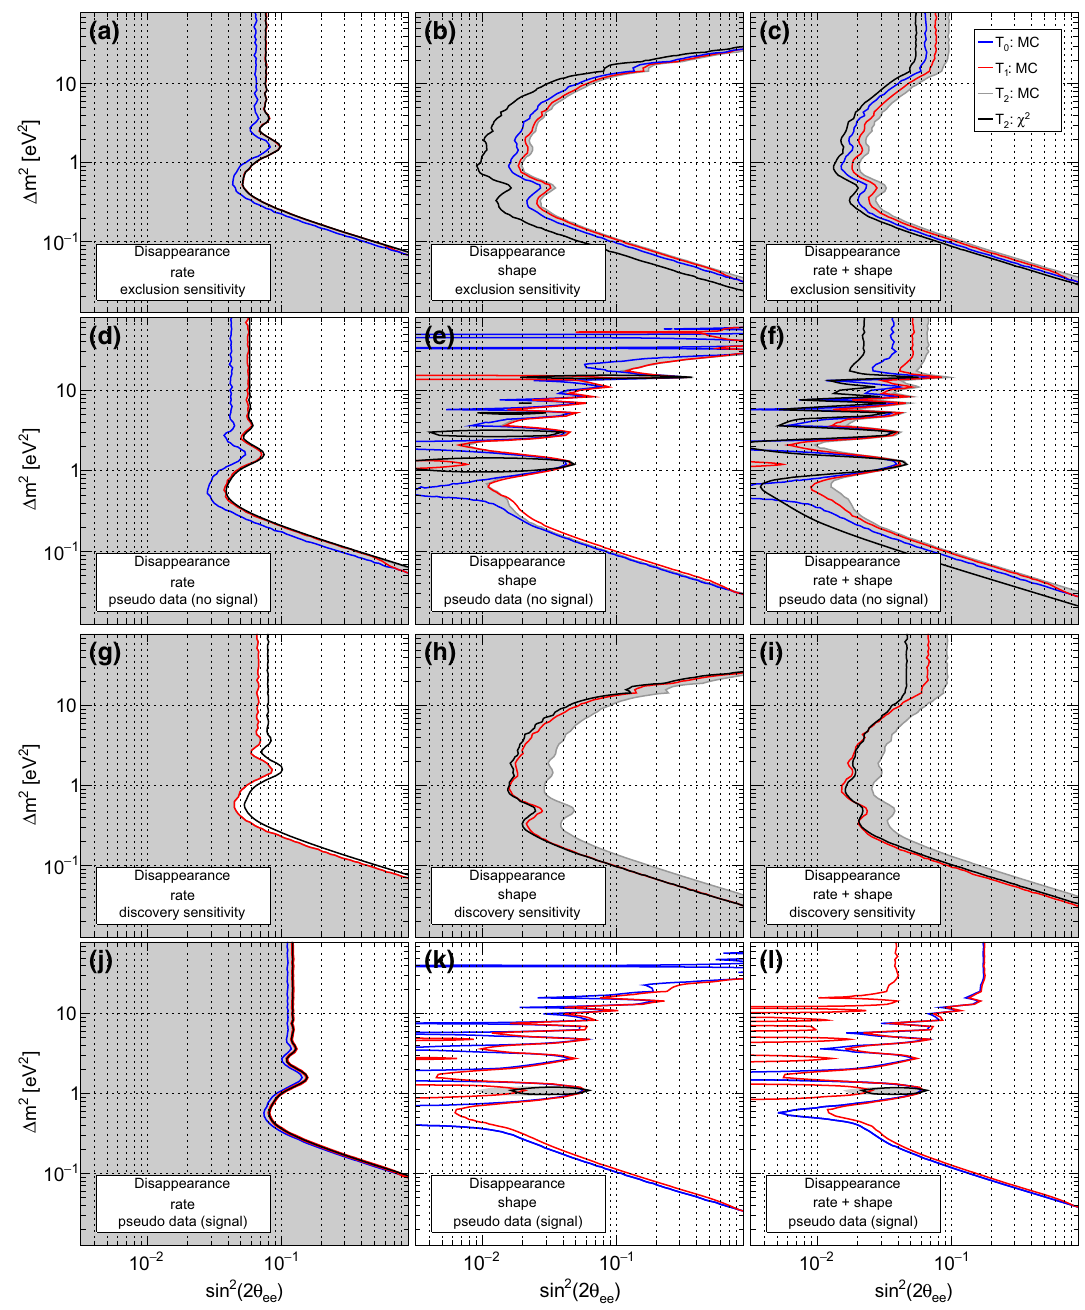
Fig. 6 Comparisonofthesensitivityandconfidenceregionsat95%CL for the toy disappearance experiment obtained with T 2 , T 1 and T 0 . The exclusion and discovery sensitivities (first and third row respectively) have been computed using 10,000 pseudo-data sets. The confidence regionsforaconcretedata-sethaveinsteadbeencalculatedforapseudo- data set generated under the no-signal hypothesis (second row) and one